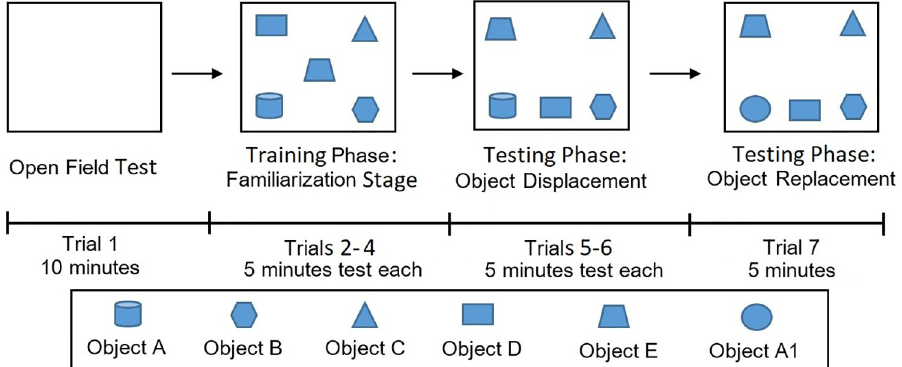
Fig 2. Design of object placements in the open field